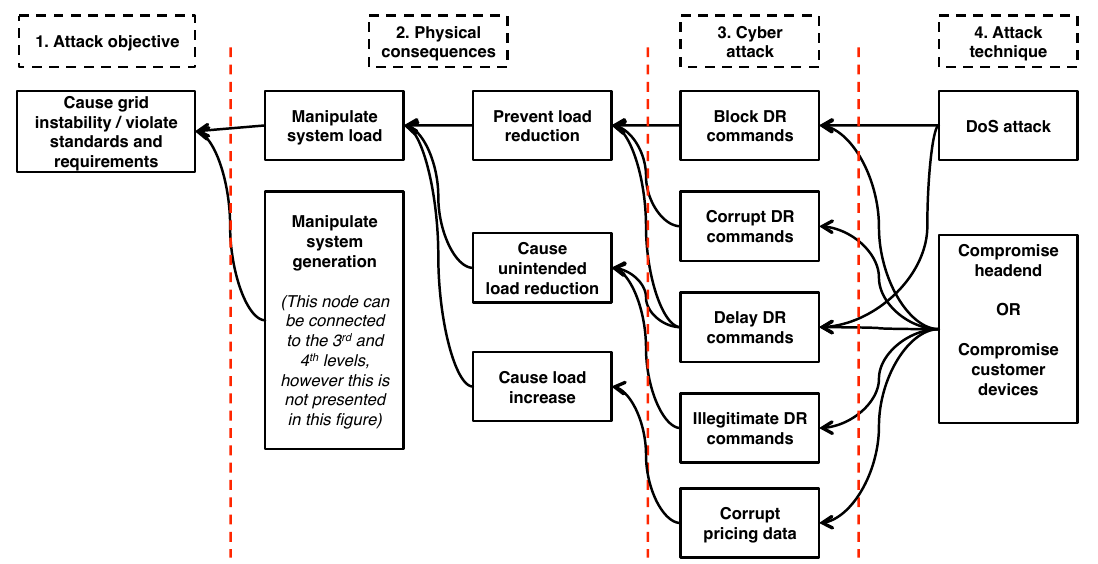
Figure 4. Attack tree for DR as spinning reserve